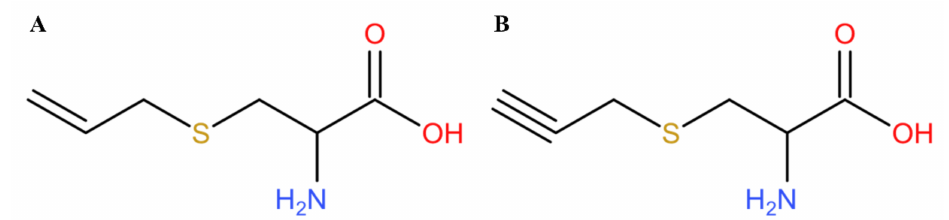
Figure 1. The chemical structure of ( A ) S-allyl-cysteine (SAC) and ( B ) S-propargyl-cysteine